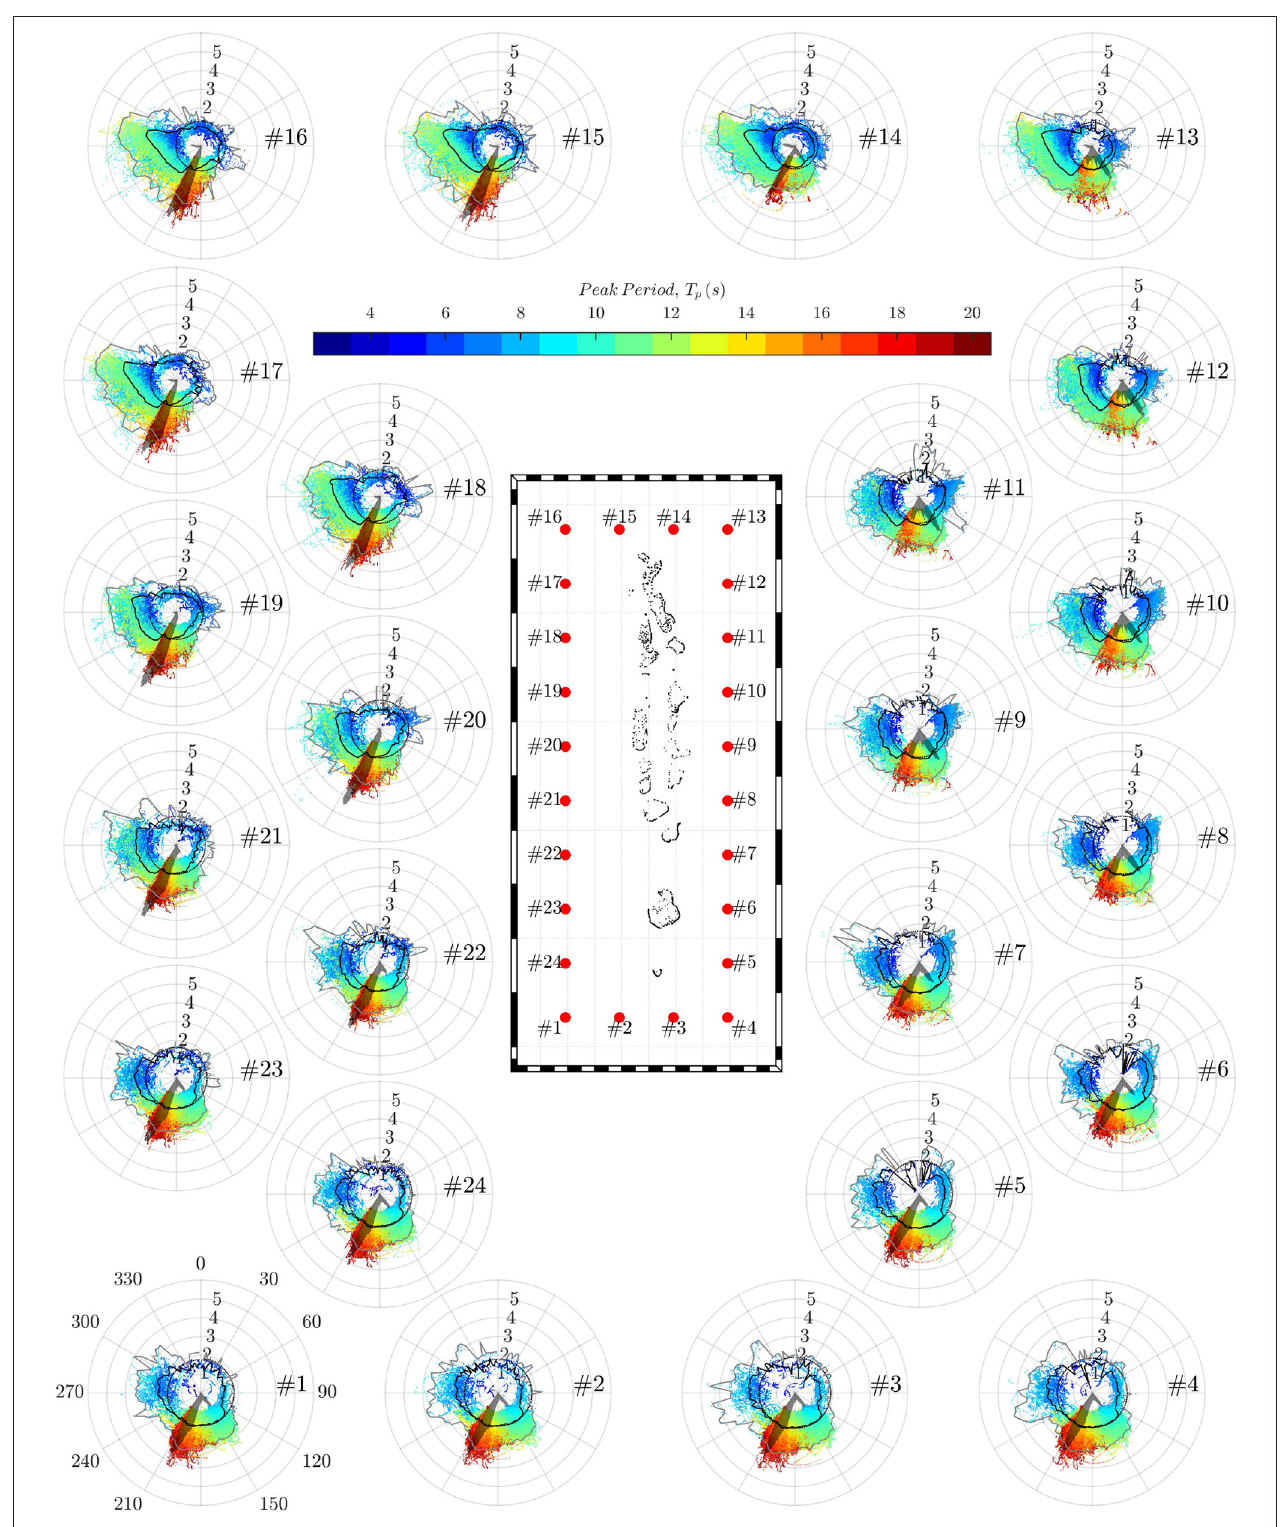
FIGURE 2 | Distribution of the ocean wave climate around the Maldives from the CFSR Hindcast. Each wind-rose-plot corresponds to one point of the central map. The radial distance of each single point in each wind-rose indicates the wave height (m) while the azimutal value indicates the direction that the waves are coming from in nautical convention. The colour of each point shows the peak period. The continuous black (grey) line indicates the quantile 50 (99) for each direction while the dashed black like shows the quantile 50 averaging all the directions. Shadowed areas in the wave roses indicate the most frequent incoming wave directions in a 1 ◦ bins (% referred to the radial